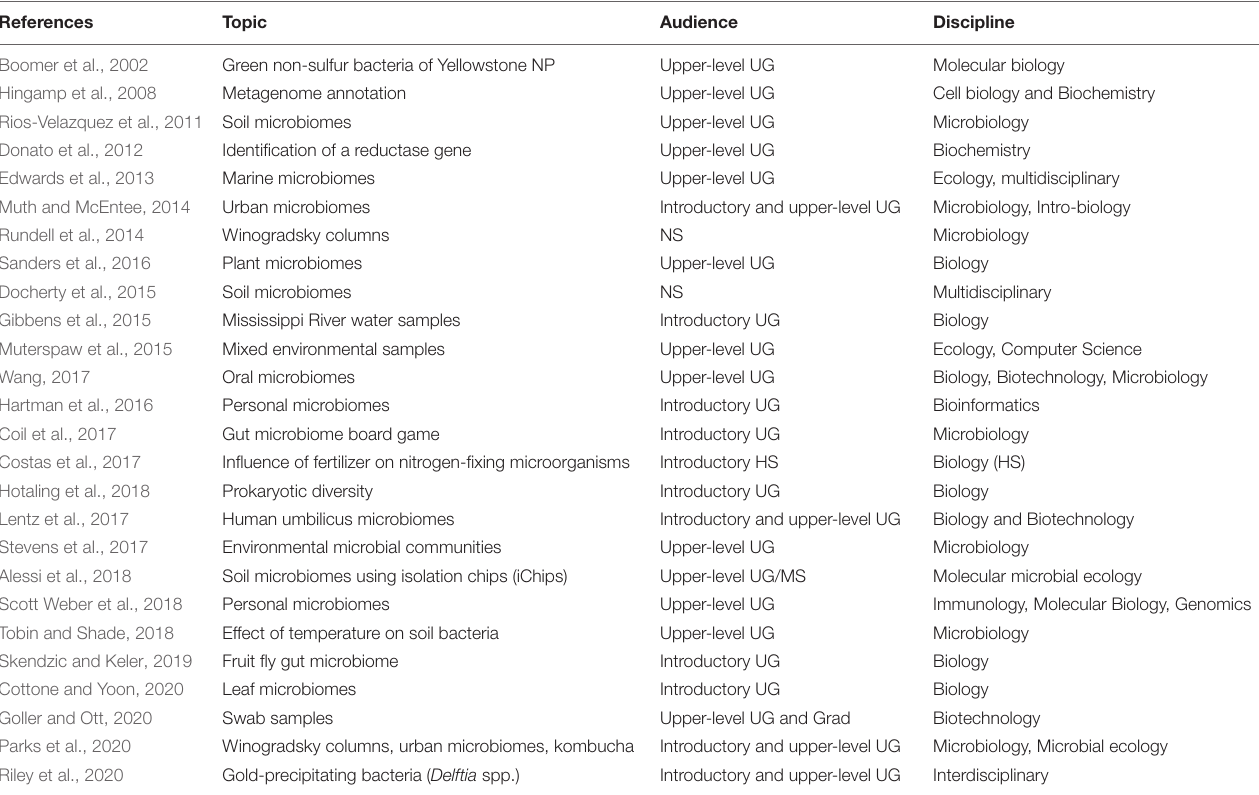
TABLE 1 | Microbiome research projects for undergraduate